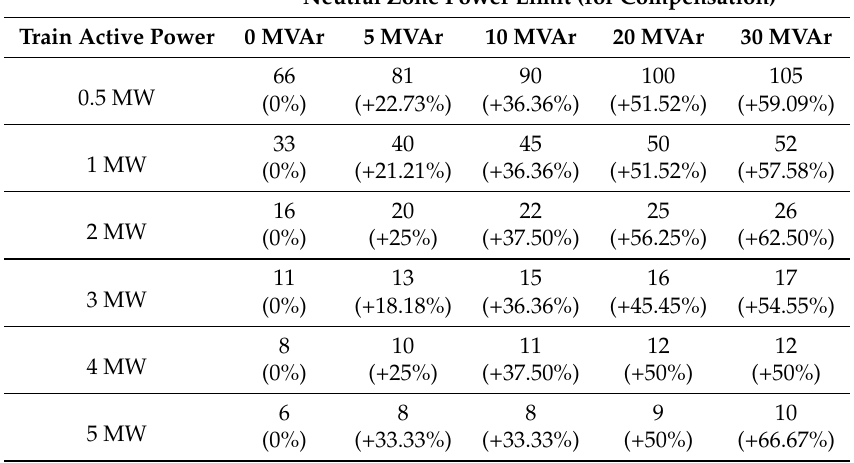
Table 2. Maximum number of trains, for different train power consumptions and for different Neutral Zone power limits. Note: the percentage improvement from baseline is presented in parentheses (where 0 MVAr means no compensation). As an example, the baseline for P T = 2 MW is 16 trains; then, for Q NZ = 20 MVAr, it is possible to have nine more trains (+56% more than